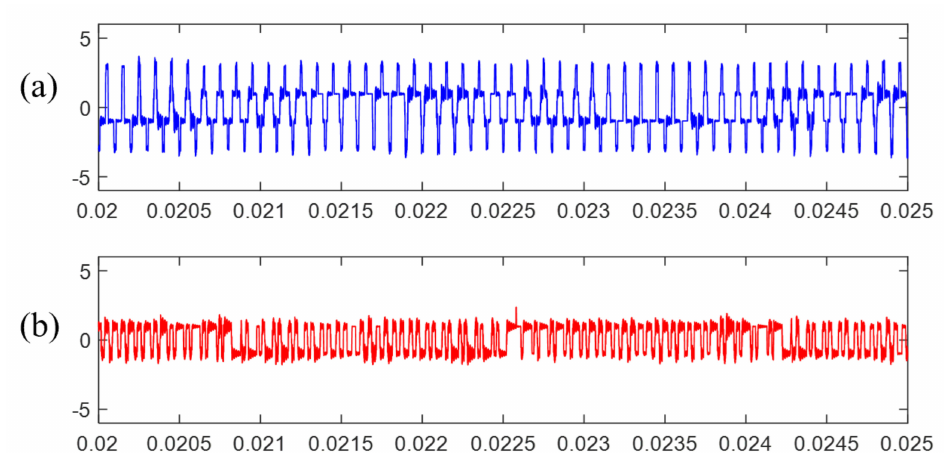
Figure 13. Comparison of shaft voltages with SVPWM and TSPWM in high modulation region (M = 0.8), respectively: ( a ) SVPWM, ( b )